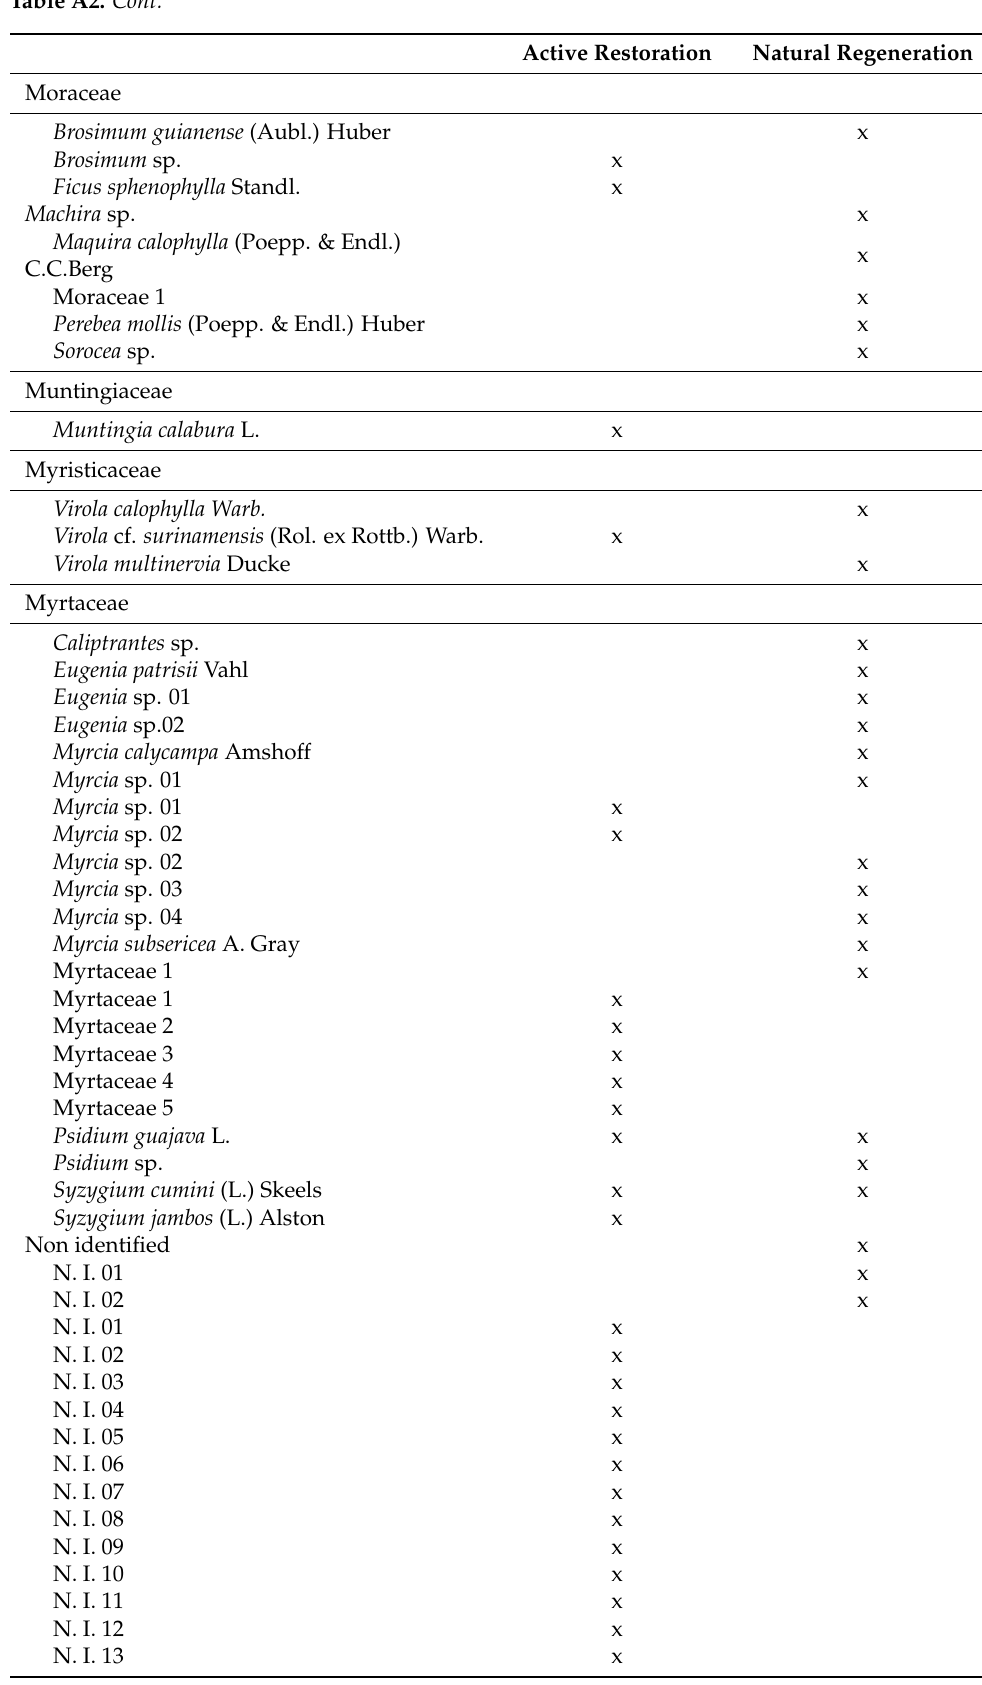
Myrcia sp. 03 Myrcia sp. 04 x Myrcia subsericea A. Gray x Myrtaceae 1 x Myrtaceae 1 x Myrtaceae 2 x Myrtaceae 3 x Myrtaceae 4 x Myrtaceae 5 x Psidium guajava L. x x Psidium sp. x Syzygium cumini (L.) Skeels x x Syzygium jambos (L.) Alston x Non identified x